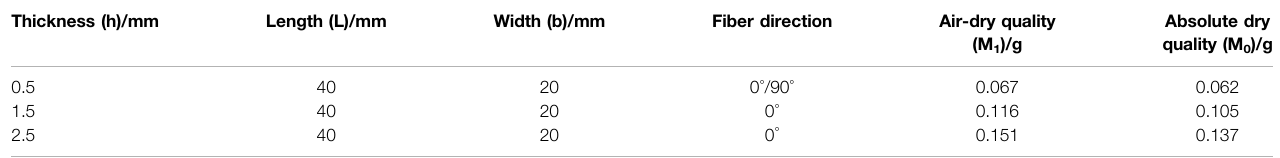
TABLE 1 | Raw material speci fi cations of poplar.